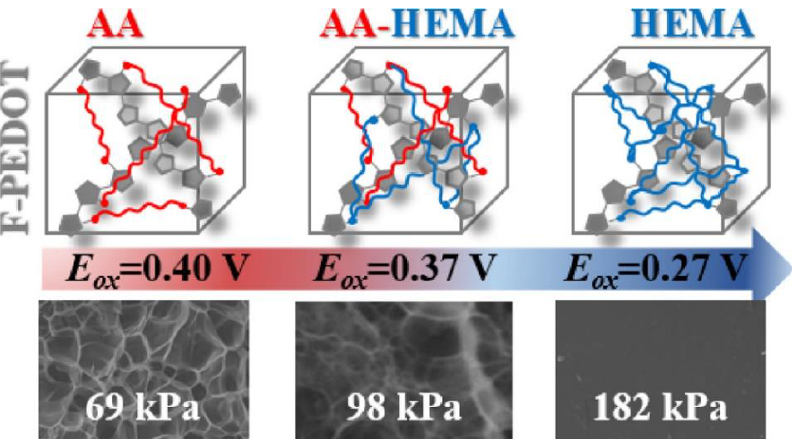
Figure 5. Fabrication process of conducting hydrogels using a copolymerization approach with vinyl monomers (reprinted with permission from ref. [71]).